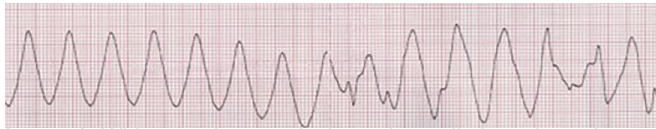
Image 2. Wide complex ventricular tachycardia in patient who ingested chloroquine phosphate aquarium